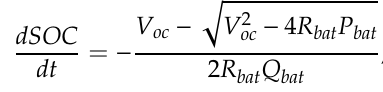
Figure 8. Characteristic curves of a lithium-ion battery pack. 3.5. Vehicle Longitudinal Dynamics Longitudinal dynamics have great influence on the performance of an automobile. When ignoring other dynamic models, the PHEB is considered to be a point mass model. The power requirement of the automobile can be derived from Equation (7): (